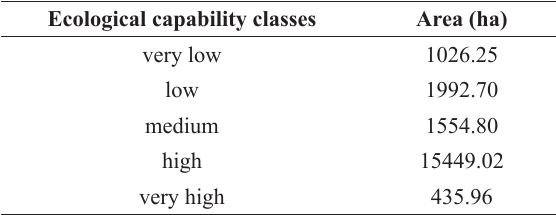
Area of overlay classes using Gamma